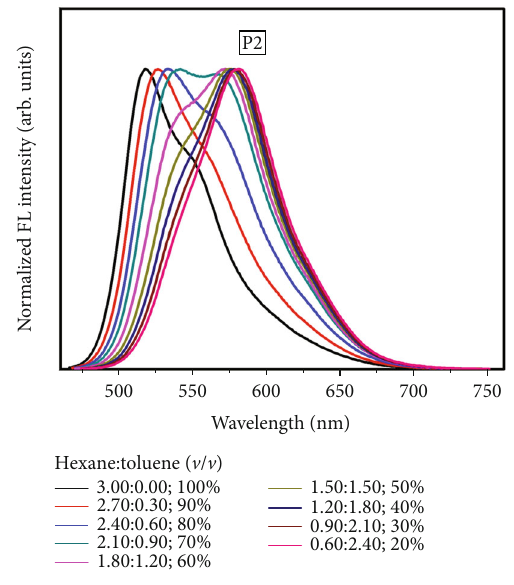
Figure 8: Normalized fl uorescence emission (excited at the corresponding absorption maximum) spectra of P2 as dilute solutions in pure hexane and mixed hexane/toluene solvents. Note that P2 has poor solubility in hexane, and the upper, clear portion of a saturated P2 solution in hexane was collected and used as the stock solution. The same amount of stock solution was used for the preparation of the solutions, and the overall concentration of P2 was kept